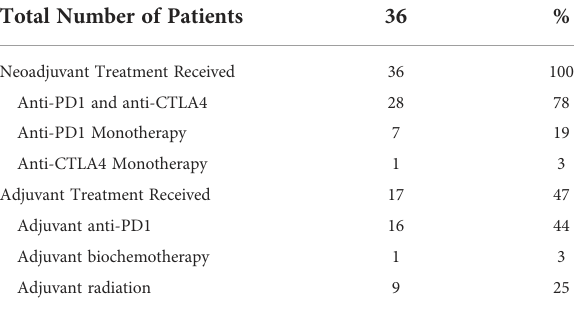
TABLE 2 Neoadjuvant and adjuvant treatment received by patients with mucosal melanoma treated with neoadjuvant checkpoint inhibitors.